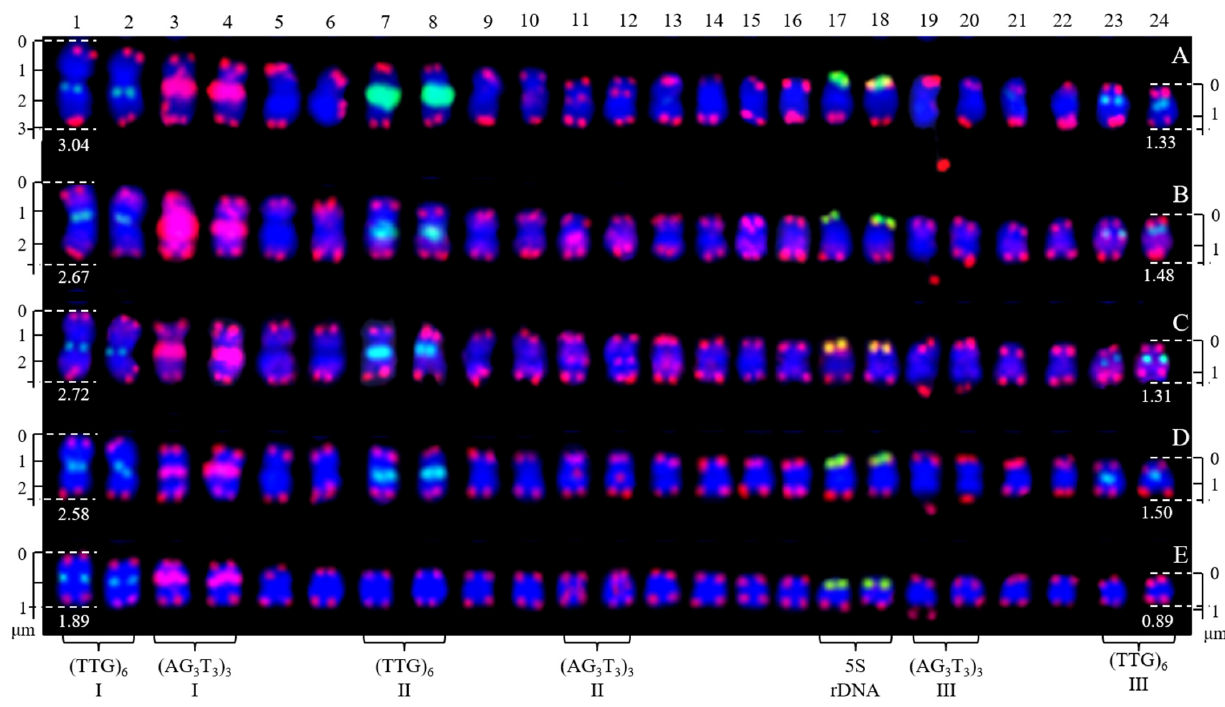
Figure 2. Chromosomes from Figure 1 presented individually. The chromosomes were aligned by a combination of length from the longest to shortest and signal pattern. The left/right number represents the chromosome length: ( A ) H. rhamnoides ‘Wucifeng’, 3.04–1.33 μ m; ( B ) H. rhamnoides ‘Shen-